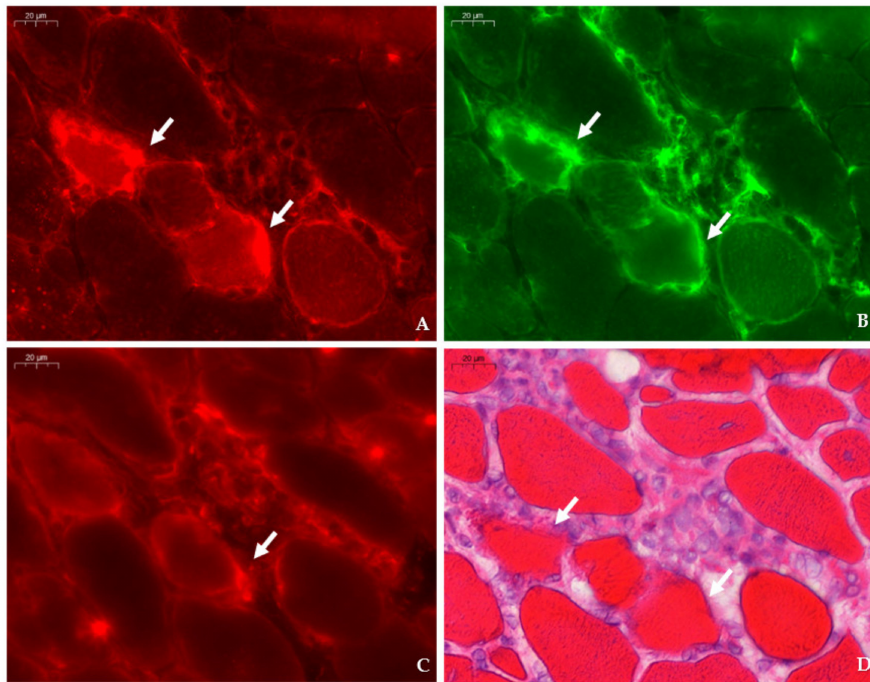
Figure 4. Expression of TauT in relation to dystrophinopathy-associated pathology in consecutive sections of the tibialis anterior in a 4 week-old mdx mouse. ( A , B ) Strong staining of TauT (CY3, red) is observed in myofibers (arrow) abutted by F4/F80 macrophages (AlexaFluor 488, green). ( C ) Staining of CD206 (CY3, red) in the consecutive section shows the presence of type II macrophages surrounding a myofiber (arrow) that corresponds to the TauT positive myofiber in panel A. ( D ) Identification of necrotic fibers (arrows) characterized by loss of membrane integrity stained with hematoxylin– eosin was performed in the same section as the immunofluorescent double stain (TauT/F4F80). Scale bars = 20 µ